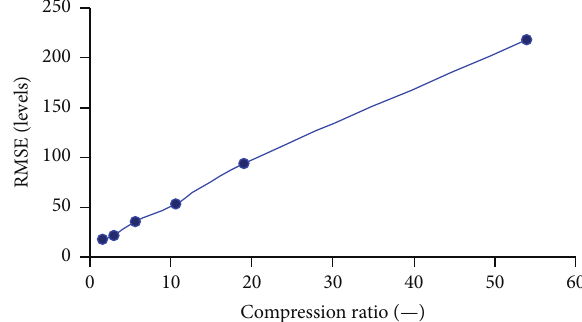
Figure 10: RMSE measurements of light image M17.dat (deep sky camera) versus compression